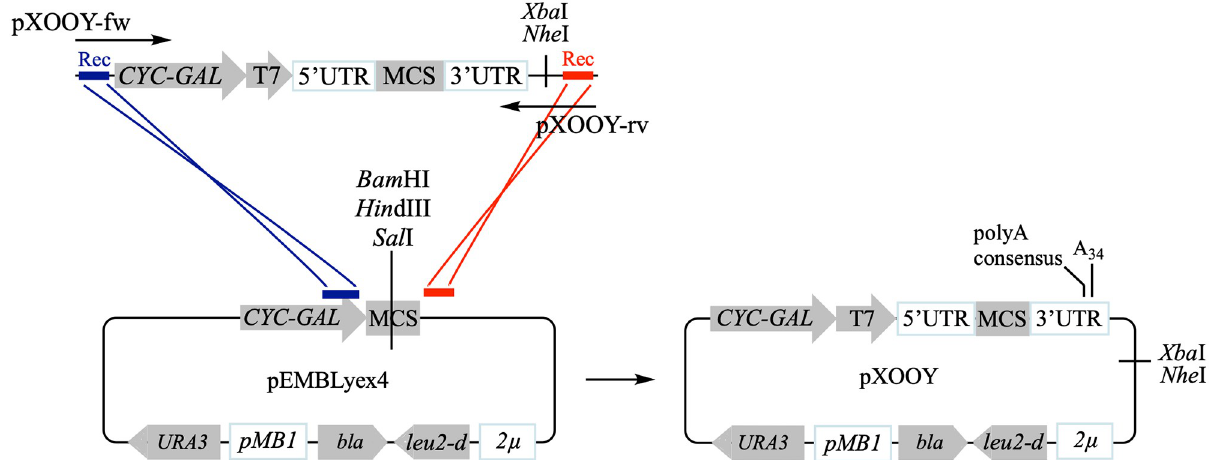
Fig 2. Illustration of how pXOOY was constructed by inserting a Xenopus -yeast dual expression cassette into pEMBLyex4. Both forward and reverse primers (pXOOY-fw and pXOOY-rv, respectively) used to amplify the Xenopus -yeast expression cassette are indicated by black arrows. Each primer contained a 5’ extension ( Rec and Rec , respectively), which was identical to either side of the MCS in pEMBLyex4. These regions of homology direct correct insertion of the PCR amplified expression cassette. The PCR fragment and pEMBLyex4 linearized at its MCS with Bam HI, Hin dIII and Sal I to prevent plasmid recircularization were co-transformed into PAP1500 cells to assemble the final pXOOY plasmid by homologous recombination (shown to the right).